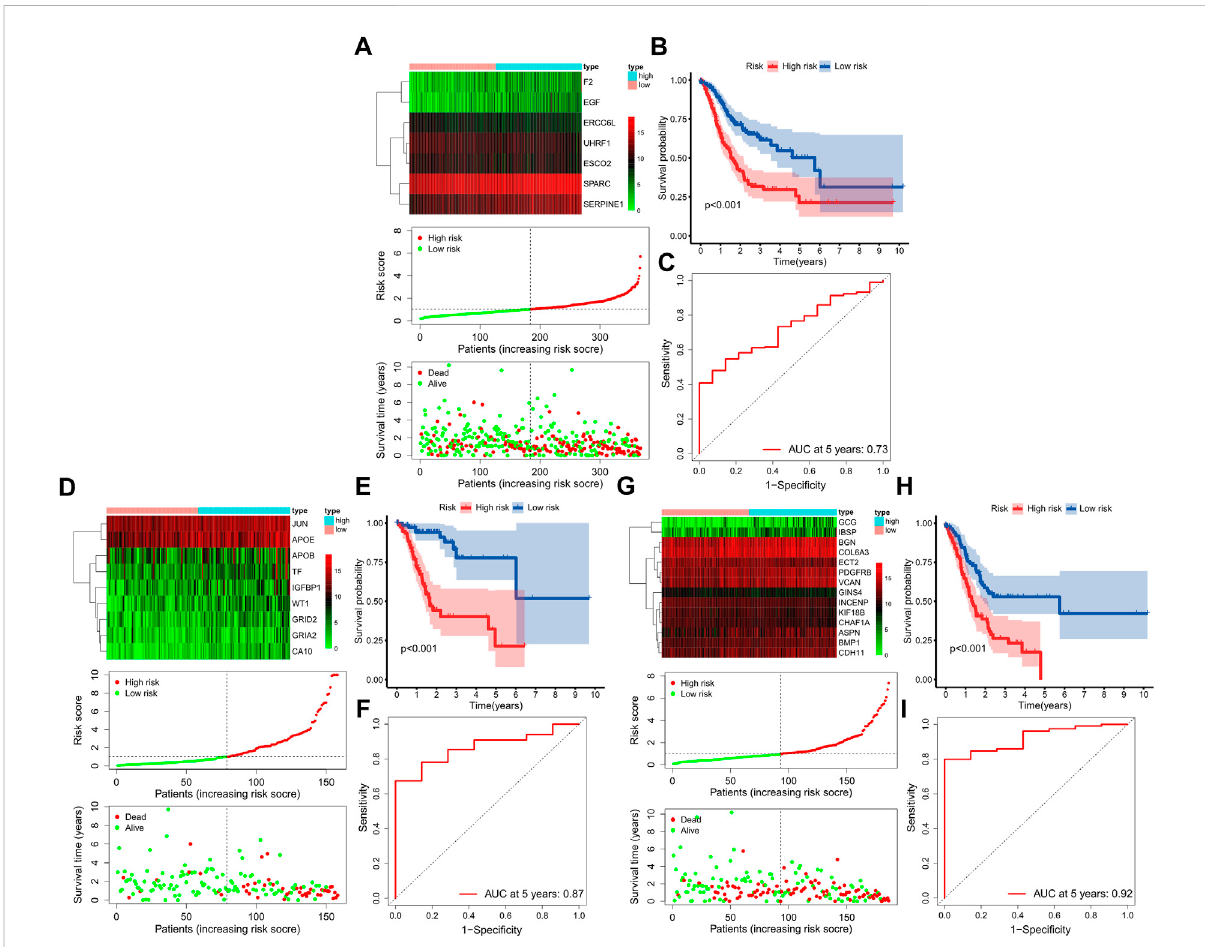
FIGURE 4 Constructionofthreeprognosticmodels.Thetop,bottomleft,andbottomrightcornerofthis fi gure(threesubgraphs)representtheSTADtotal samples group (A – C) , STAD samples in the early-stage group (D – F) , and STAD samples in the progressive-stage group (G – I) . (A,D,G) From top to bottomofeverysubgrapharetheexpressionheatmap,riskscorecurve,andsurvivalstatusmapbetweenthelow-riskandhigh-riskgroups.Thecolor bar reveals the relative mRNAs-PRO expression level, with red denoting high expression and green denoting low expression. (B,E,H) Survival curve for the low-risk and high-risk groups. (C,E,I) ROC curve for survival